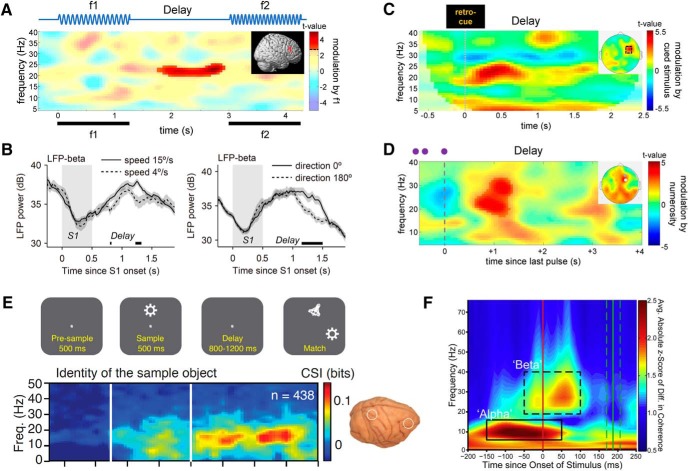
Content-specific beta activity during WM processing. A, During WM maintenance of vibrotactile frequency information, prefrontal EEG beta power is parametrically modulated by the frequency of the to-be-maintained stimulus (f1). Adapted with permission from Spitzer et al. (2010). B, Similar beta power modulations were found in LFP recordings in monkey PFC during WM maintenance of visual motion information. Adapted with permission from Wimmer et al. (2016). Note that in standard delay tasks, beta modulations occurred mostly late in the WM delay period. C, In contrast, when participants were retro-cued to focus on a given WM content for further maintenance, beta was modulated early after the cue. Adapted with permission from Spitzer and Blankenburg (2011). D, Similar transient modulations were observed during WM processing of the approximate number of previously presented inputs (three to eight pulses in rapid sequence, illustrated in purple). Adapted with permission from Spitzer et al. (2014a). E, Content-specific fronto-parietal beta-synchronization during WM maintenance of visual object information in monkeys. As in A–D, these effects were absent during stimulus encoding. Adapted with permission from Salazar et al. (2012). Reprinted with permission from AAAS. F, Rule-dependent beta-synchronization in monkey PFC at the time of the to-be-evaluated stimulus (see also Fig. 4C). Adapted with permission from Buschman et al. (2012). Reprinted with permission from Elsevier.